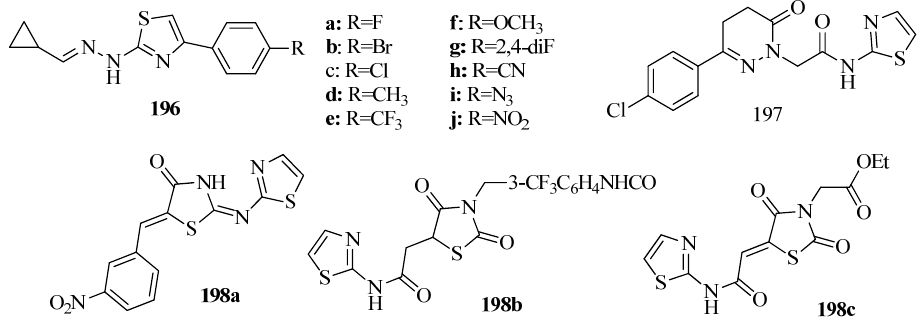
Figure 74. Structures of hydrazinylthiazole, hybrid pyridazinone–thiazole derivatives.